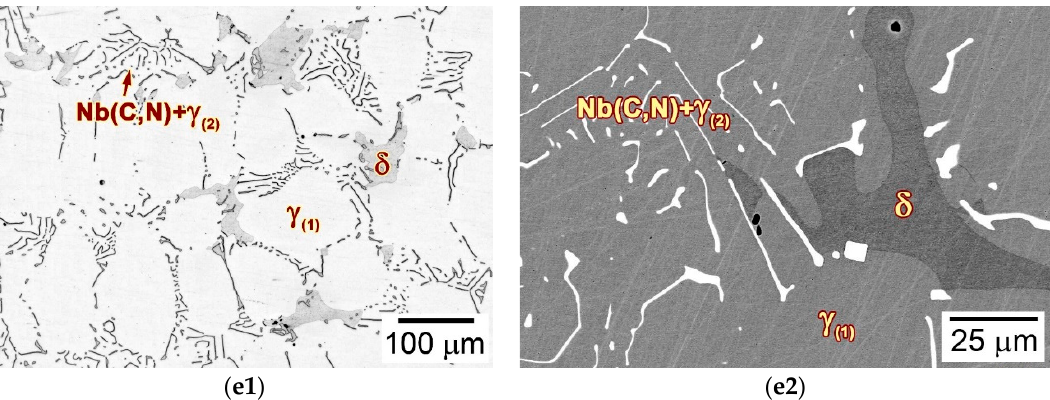
Figure 8. Optical and enlarged SEM-BSE images showing the typical microstructure of each solidification stage marked by red circles in Figure 6a under the withdraw rate of 20 µ m/s: ( a1 , a2 ) stage I; ( b1 , b2 ) stage II; ( c1 , c2 ) stage III; ( d1 , d2 ) stage IV; ( e1 , e2 ) stage V.